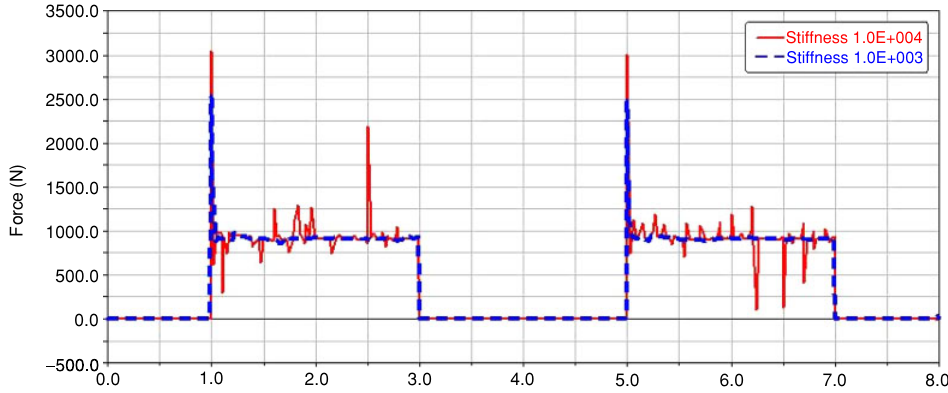
Figure 10 Effect of foot’s stiffness on the contact force.